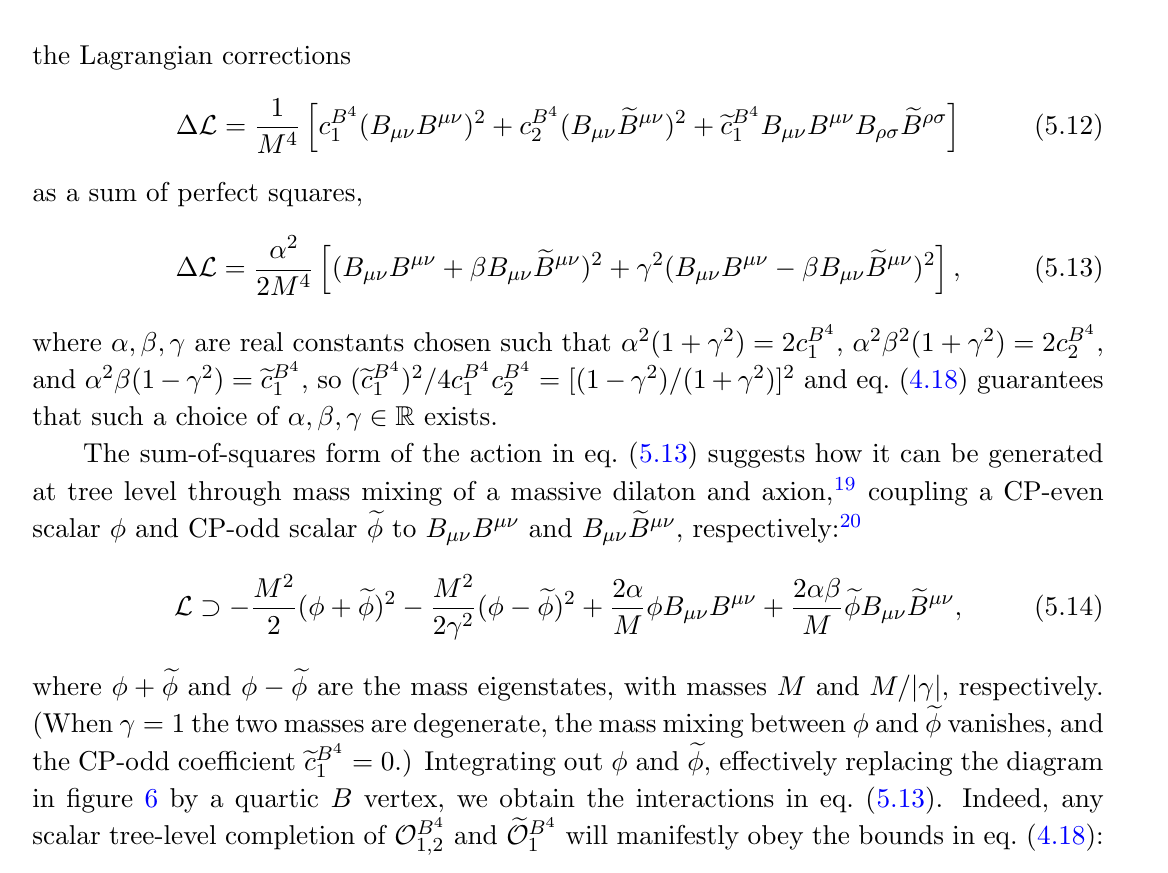
Figure 6 . Tree-level interaction between four U(1) Y gauge bosons, mediated by a CP-even scalar (cid:30) , a CP-odd scalar (cid:30) , and their mixing. When these states are integrated out, CP even and odd B 4 operators are generated, and their coe(cid:14)cients satisfy our bound on the CP-odd coe(cid:14)cient given in e eq. (4.18), in detail (~ c B 4 ) 2 < 4 c B 4 c B 4 1 1 2